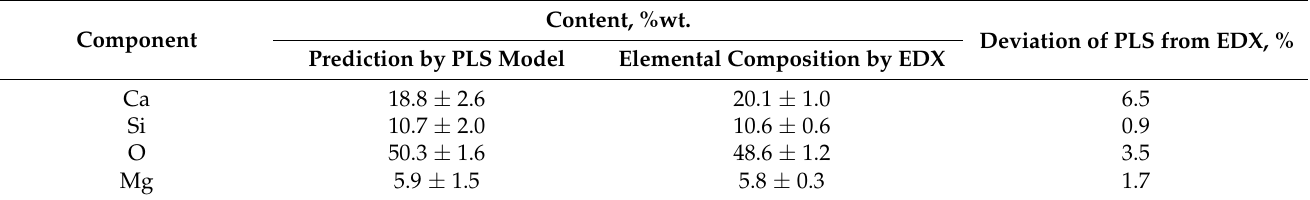
Table 7. Assignment of spectrum bands to components of the chemical composition of granulated blast furnace